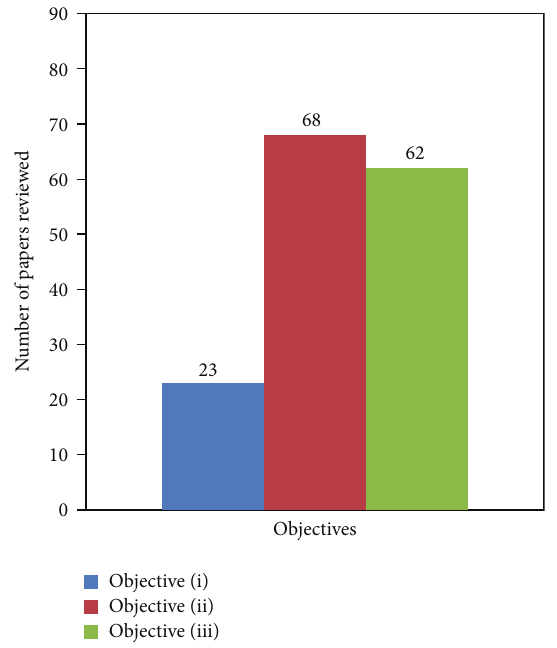
Figure 3: Publications reviewed for the subcategories of objective